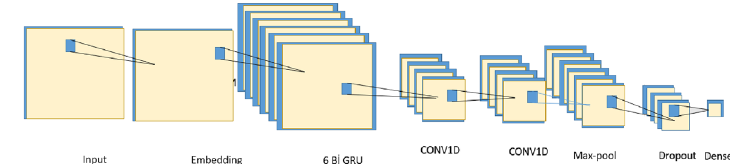
Fig. 9 The Proposed Mbi-GRUMCONV model for sentiment analysis